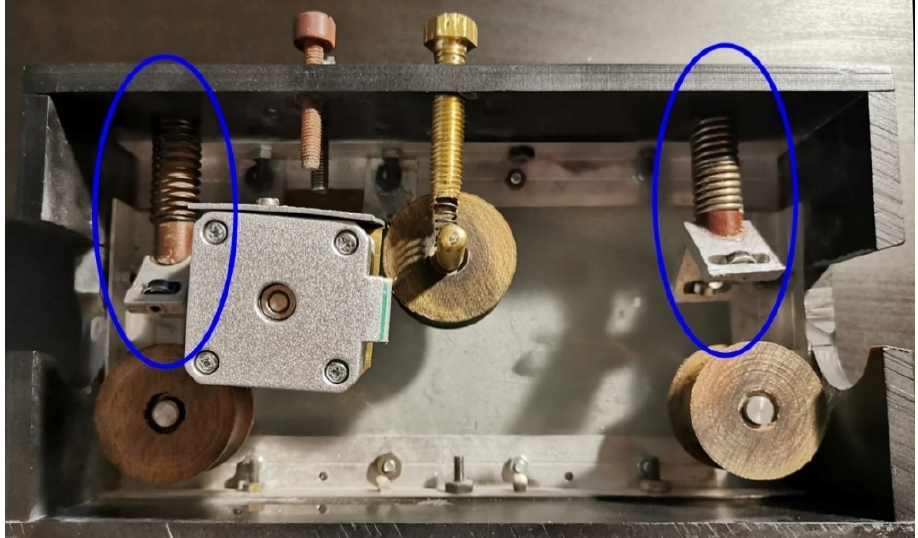
Figure 5. Supports to eliminate the torque.